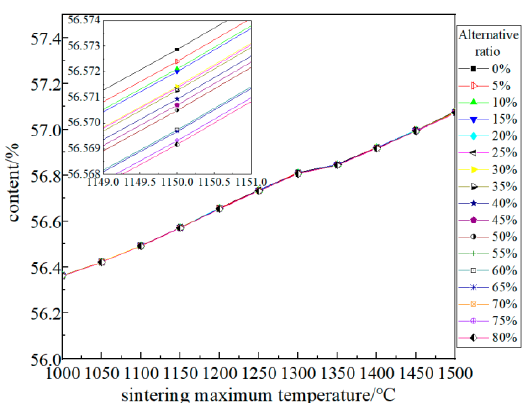
Figure 1. Change of Fe content with straw charcoal substitution.